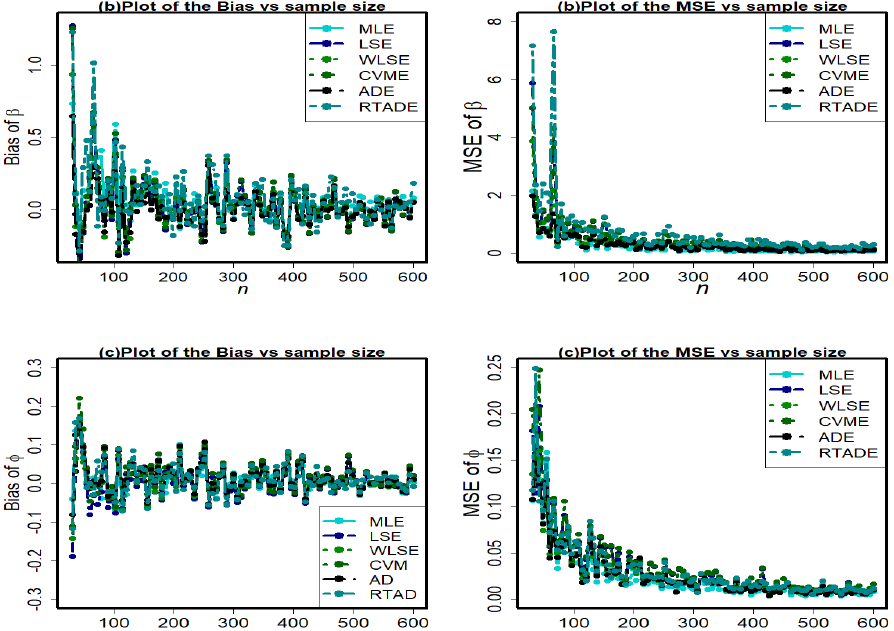
Figure 9. Plots of biases and MSEs for the parameters λ = 1.5, β = 1.3 and φ = 1.2 of HLUG-TI model. Fig. 9. Plots of biases and MSEs for the parameters (cid:21) = 1 : 5 ; (cid:12) = 1 : 3 and (cid:30) = 1 : 2 of HLUG-TI model.